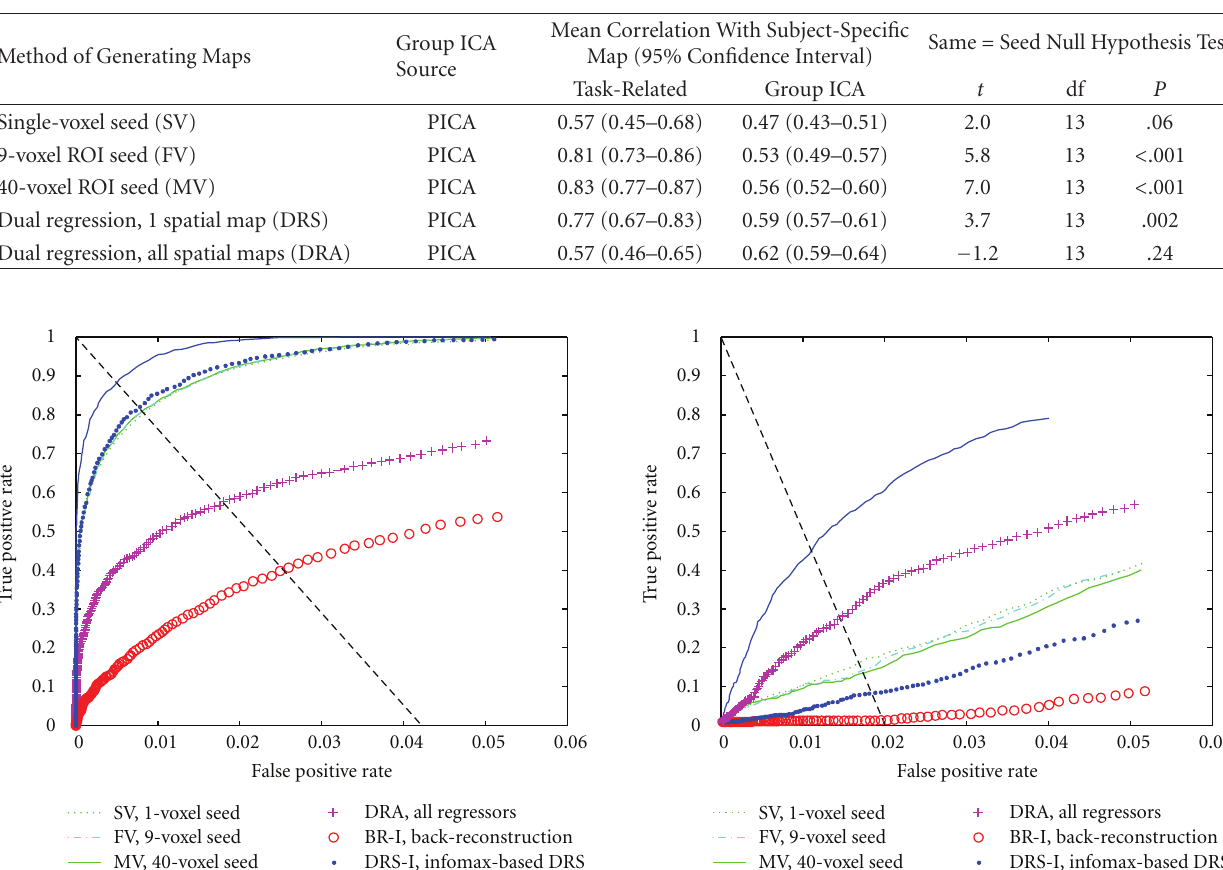
Table 5: Experiment 4: mean correlations of subject-specific FC spatial maps with (1) the task-related GLM map for the same subject (“Task- Related” column) and (2) the group IC of interest (“Group IC” column). Results of a paired t -test comparison of the mean correlations are shown in the rightmost columns. These results were based on a group ICA that produced 5 components.